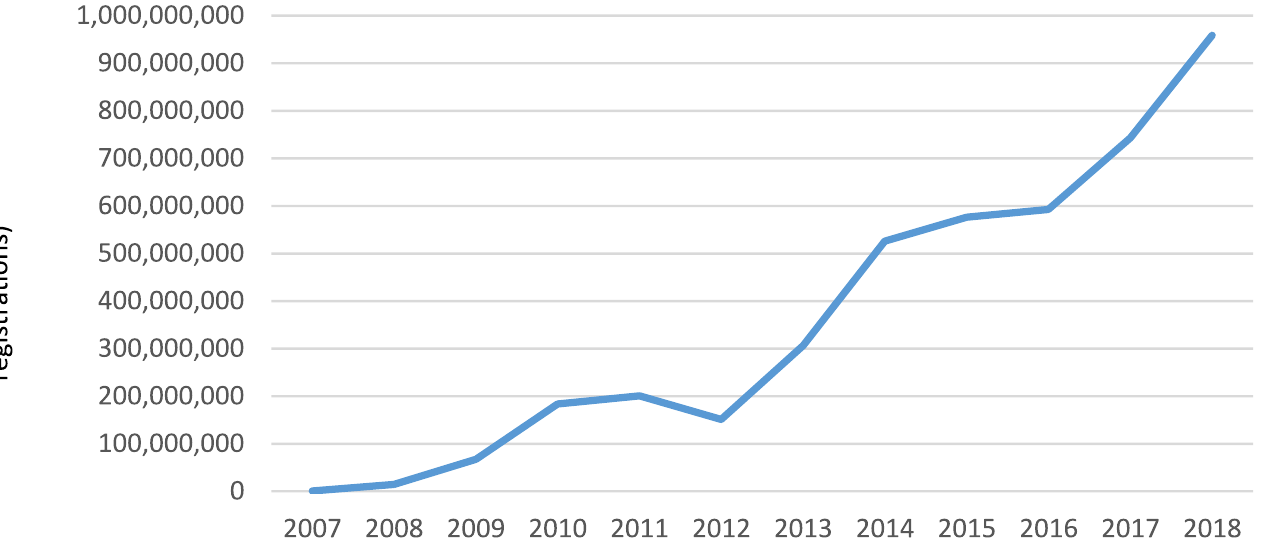
Figure 2: Number of records (e.g. hospital episodes of care, cancer registrations, and death registrations) released annually by the